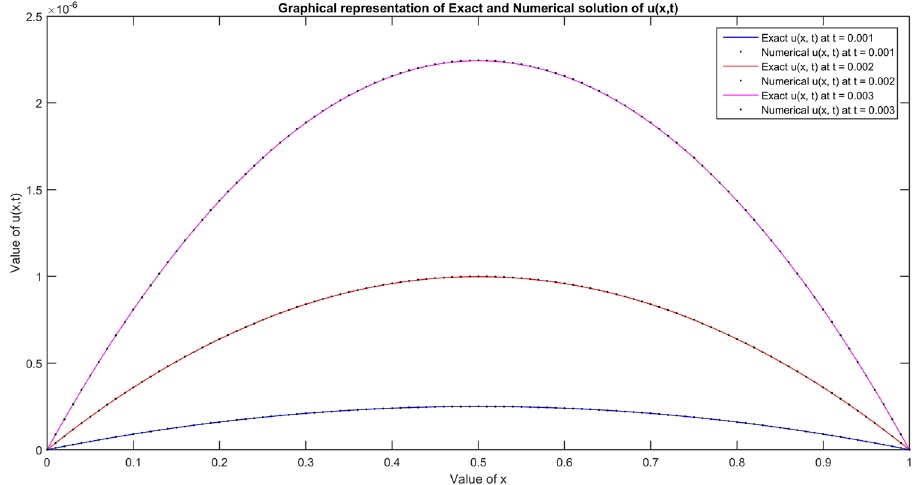
Figure 4: Comparison of results of ( ) u x t , at = t 0.001 , 0.002, and 0.003 with = N 101 , = α 0.008 , = β 0.008 , = t Δ 0.0001 , = τ 0.5 using Method II regarding Example 2.